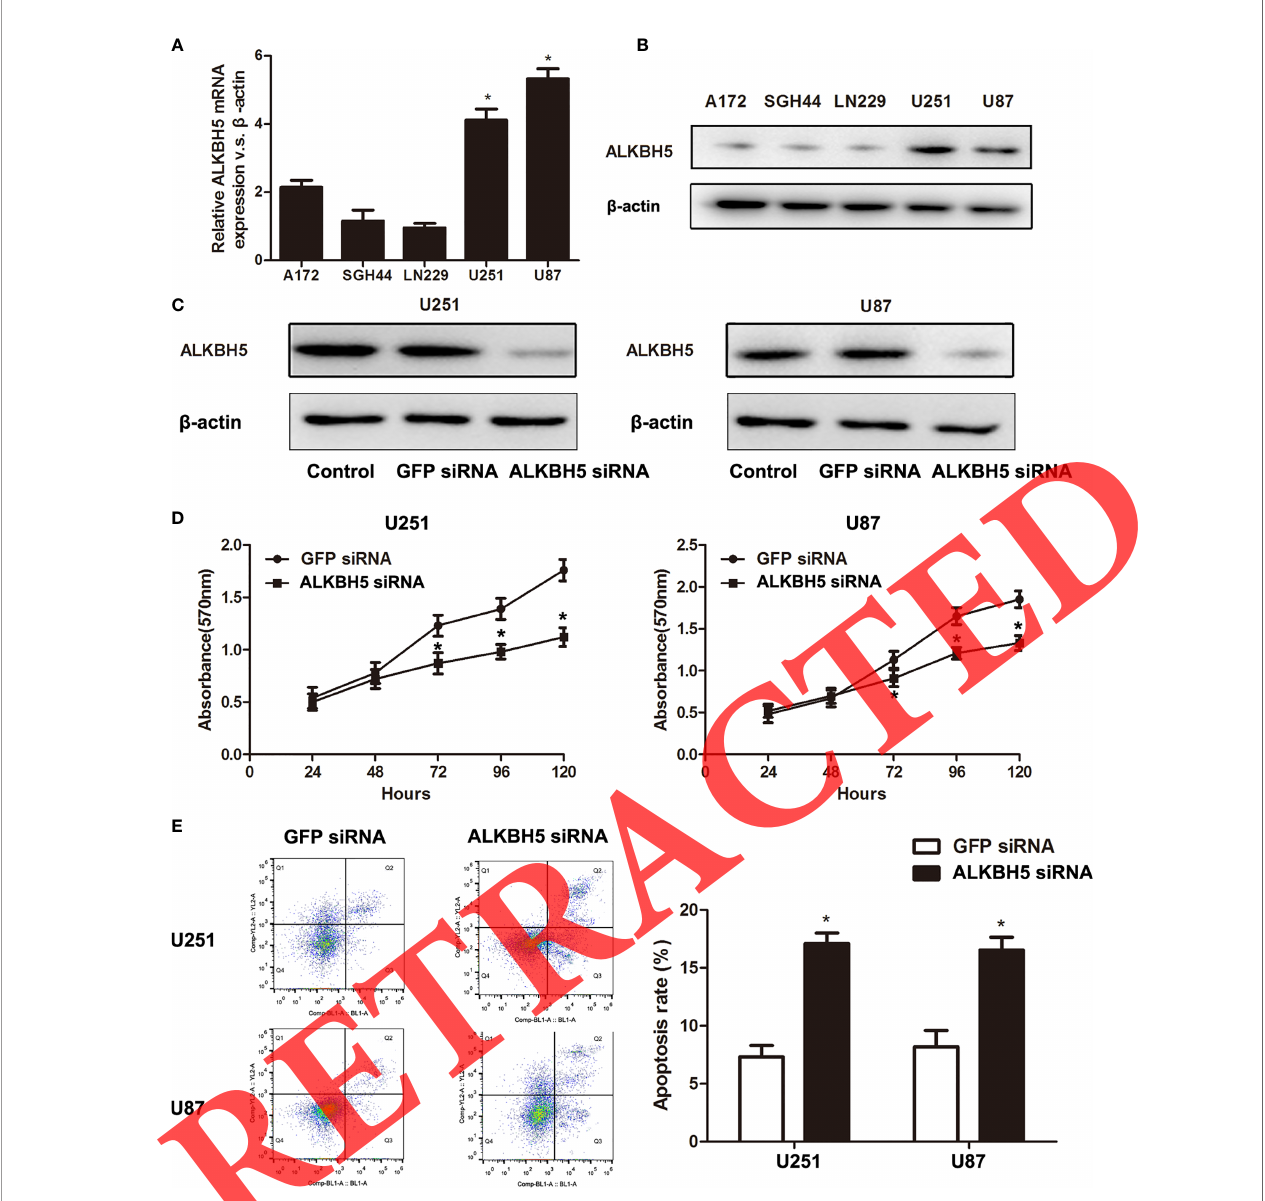
FIGURE 4 | (A) Expression mRNA levels of ALKBH5 in glioma cell lines (A172, SGH44, LN229, U251, and U87) were determined by qRT-PCR. *P<0.05. (B) Expression protein levels of ALKBH5 in glioma cell lines (A172, SGH44, LN229, U251, and U87) were determined by Western-blot analysis. (C) Expression of ALKBH5 was signi fi cantly decreased in U251 and U87 cells transfected with ALKBH5-targeted siRNA by Western blot. (D) Effect of ALKBH5 knockdown on U251 and U87 cell proliferation as measured by MTT assay at 24, 48, 72, 96, 120h. *P<0.05. (E) The number of apoptotic cells was signi fi cantly higher in U251 and U87 cells transfected with ALKBH5-targeted siRNA as measured by fl ow cytometry.